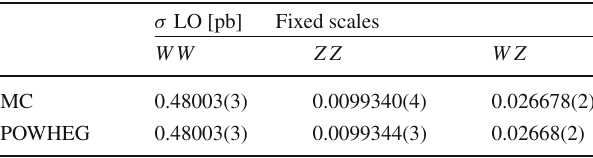
Table 2 Integrated cross sections for the processes pp → e + ν e μ − ν μ ,